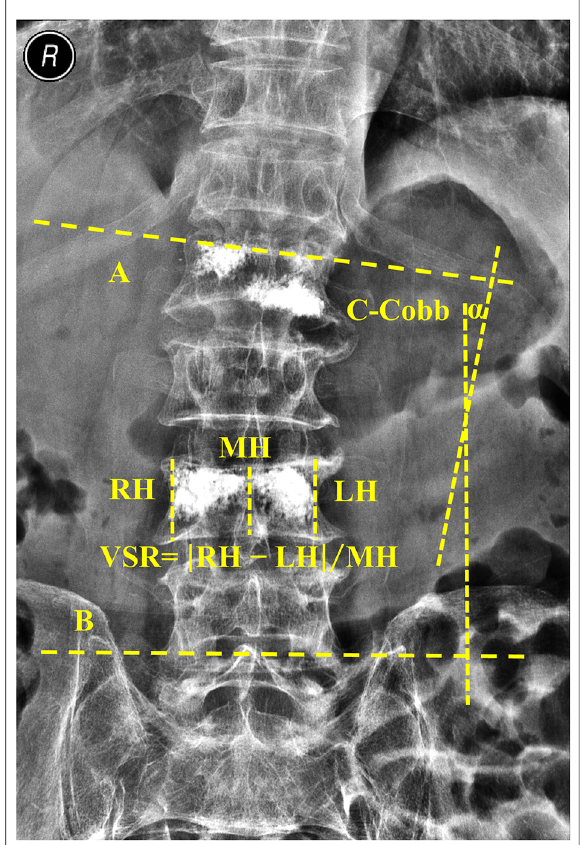
FIGURE 1 Measurements of coronal segmental cobb (C-cobb) and the vertebral side ratio (VSR). The heights of both left (LH), right (RH), and middle (MH) vertebral bodies were measured through an anteroposterior radiograph as shown in the Figure. The VSR was calculated as the following formula: VSR=|RH – LH|/MH. The Coronal Segmental Cobb (C-Cobb) angle α was measured from an anteroposterior radiograph by recording the angles between line A and line B, which were drawn parallel to the cranial and caudal most-tilted vertebral endplates.